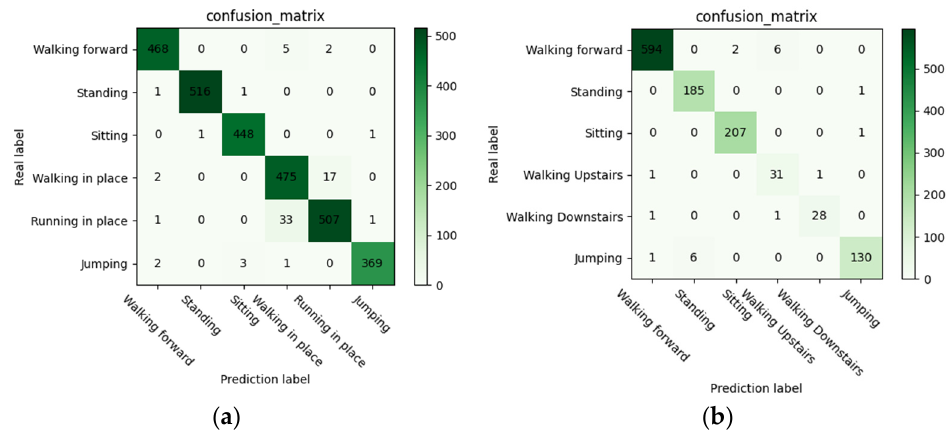
Figure 10. Confusion matrices obtained for the combination of inertial sensor data and stretch sensor data using the IS-Data dataset ( a ) and for the combination of inertial sensor data and stretch sensor data using the w-HAR dataset ( b ). Table 5. The recognition precision, recall, and F1 score for various activities in the IS-Data dataset (%). Precision Recall Walking forward